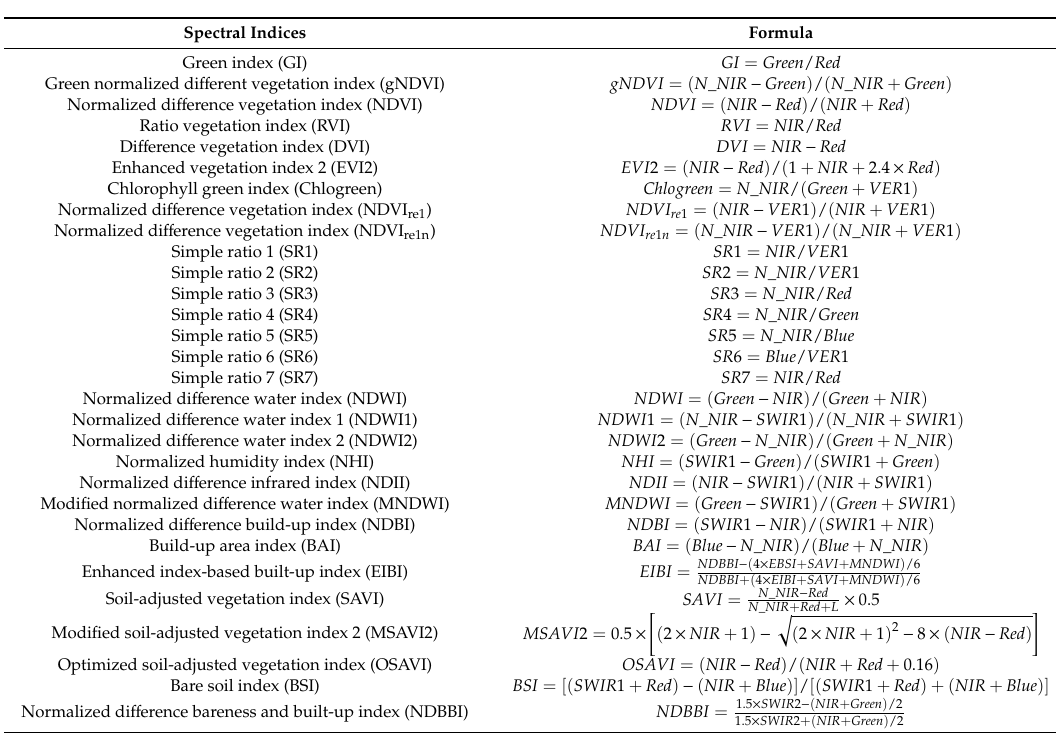
Table A2. Formulas used for calculating spectral indices